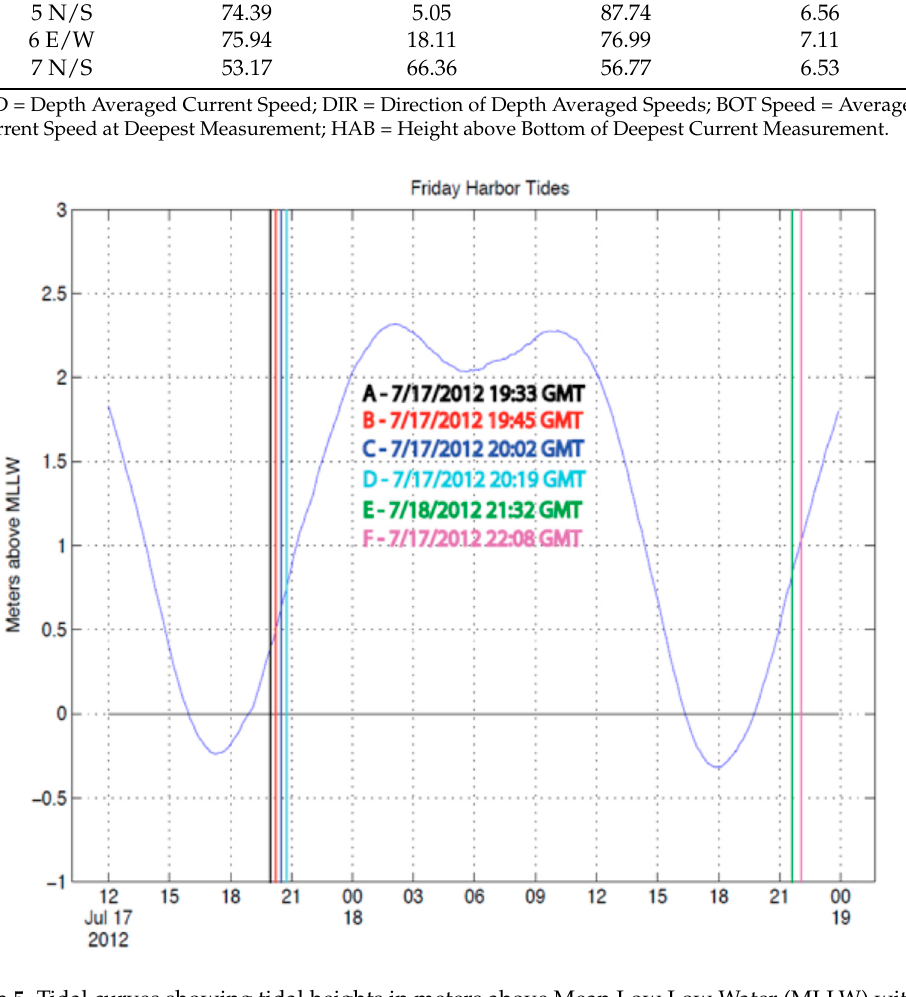
Figure 5. Tidal curves showing tidal heights in meters above Mean Low Low Water (MLLW) within the San Juan Channel for the time of the ADCP survey on 17 July 2012. Data from NOAA tide